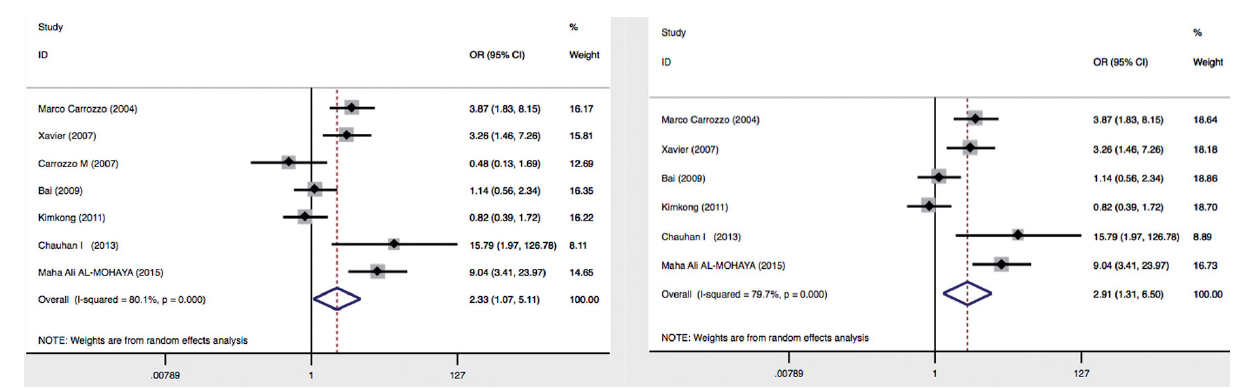
Figure 2- Summary of meta-analysis results. Left panel: Meta-analysis with a random-effects model for the association between OLP risk and the TNFα -308 G/A polymorphism (AA+AG vs. GG). Total random effects p= 0.03. Right panel: Meta-analysis excluding the HCV+ population study. Total random effects p=0.009. For each study, the estimate of OR and its 95%CI is plotted with a box and a horizontal line